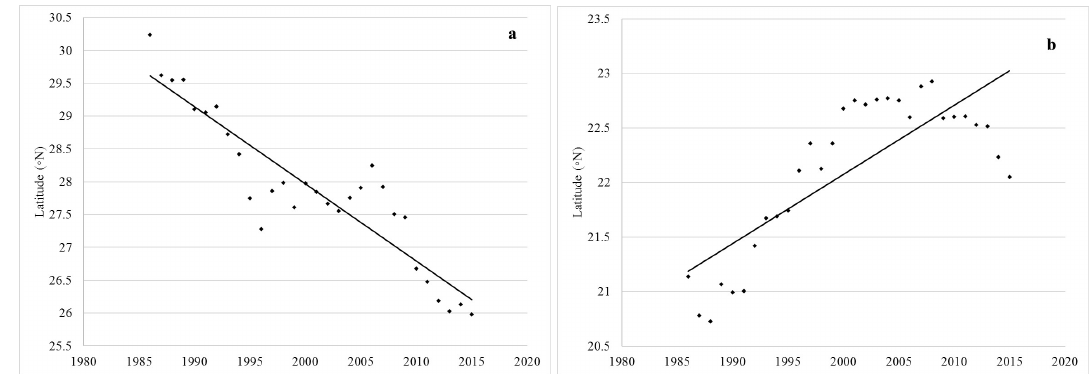
Figure 4. Moving decadal means of LMI latitude in the ( a ) North Atlantic and ( b ) West Pacific basins. The significant linear trends of LMI latitude are shown with a solid line.